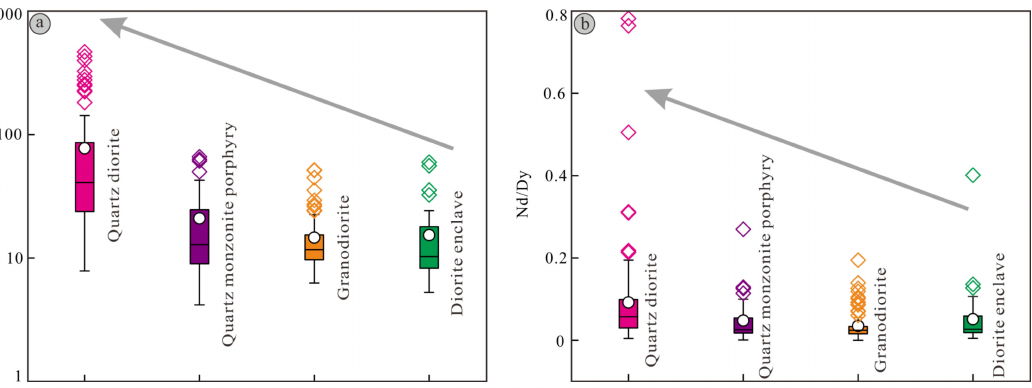
Figure 14. The zircons ( a ) oxygen isotopic composition, ( b ) P concentrations, and ( c ) oxygen fugacity diagram of Yangla granitoids plutons and Peninsular Ranges Batholith. The zircon δ 18 O values of granodiorite sourced by Zhu et al. (2011) [2]; The δ 18 O values, P concentrations, and oxygen fugacity ( f O 2 ) of the high-Sr/Y, transition and eastern zone, and western zone plutons were referred from the Bell et al. (2019) [91] and Bell and Kirkpatrick (2021) [87].